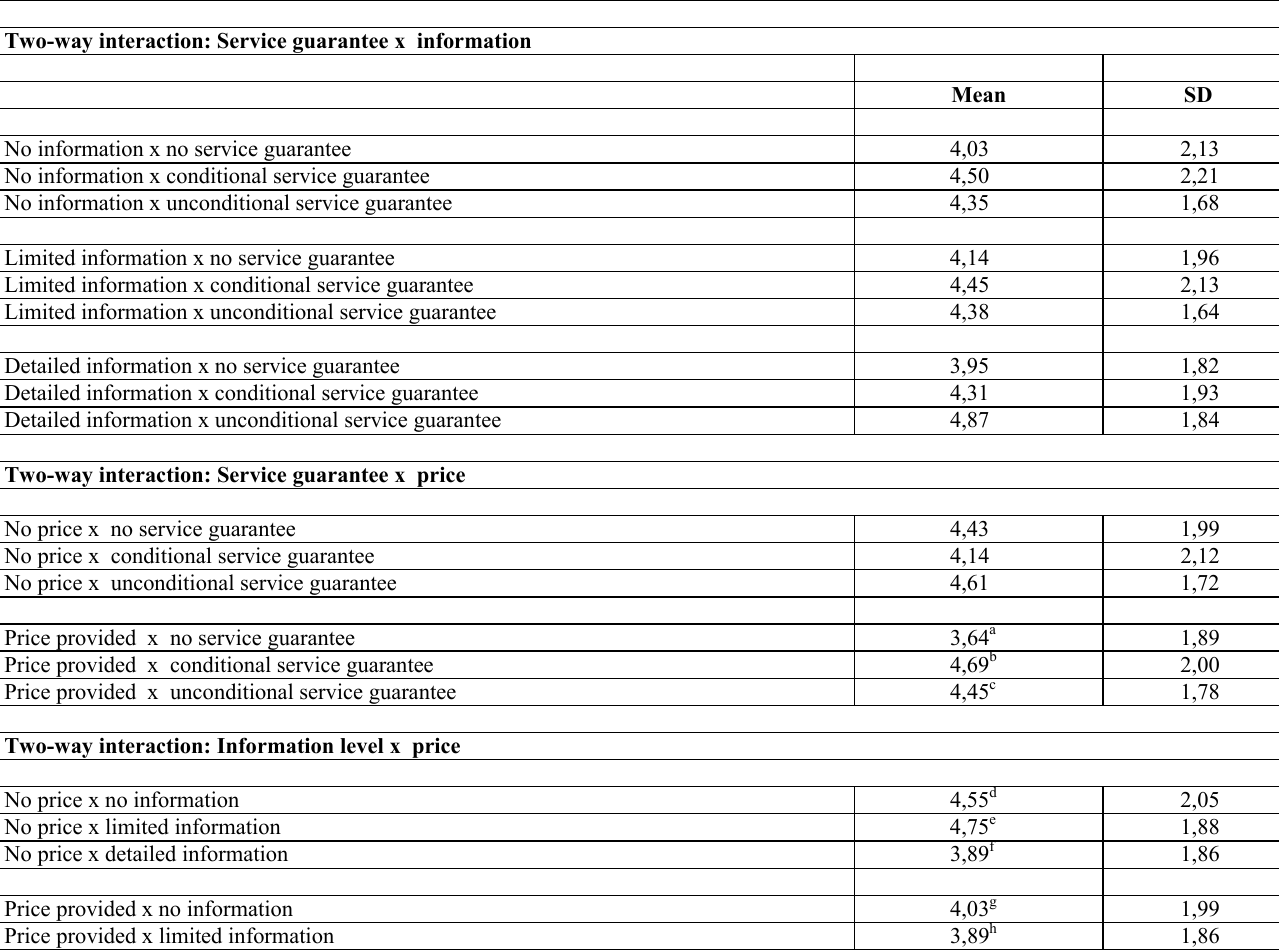
Table 2: Duncan’s multiple range test results: two way